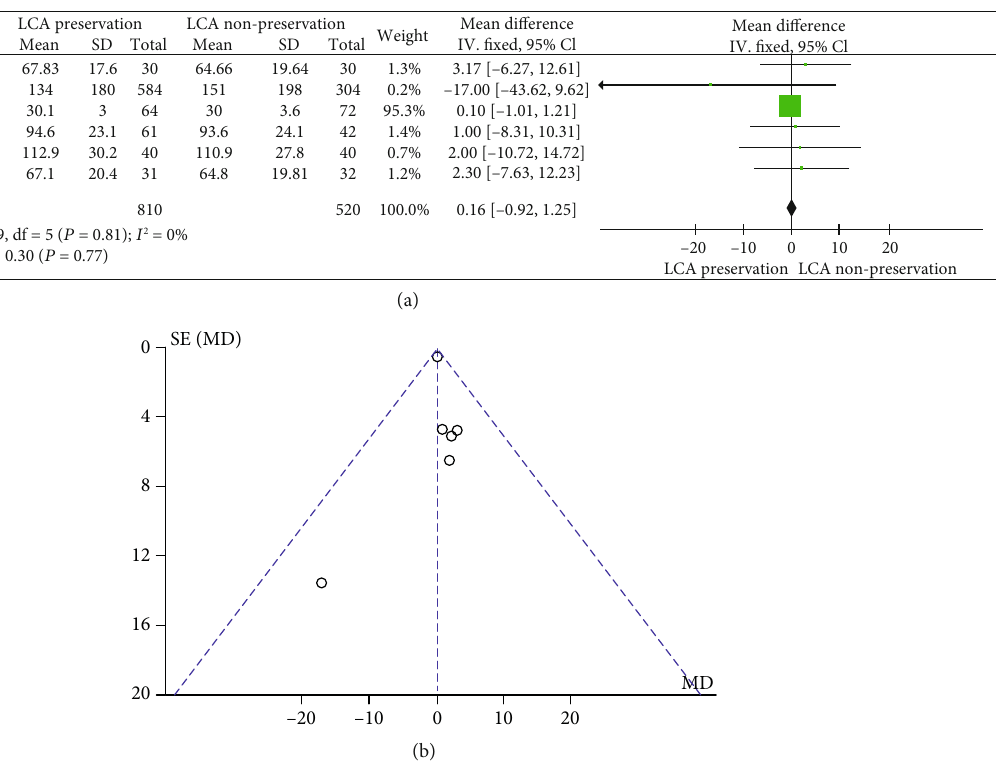
Figure 4: (a) Forest plot of intraoperative blood loss; (b) funnel plot of intraoperative blood loss.